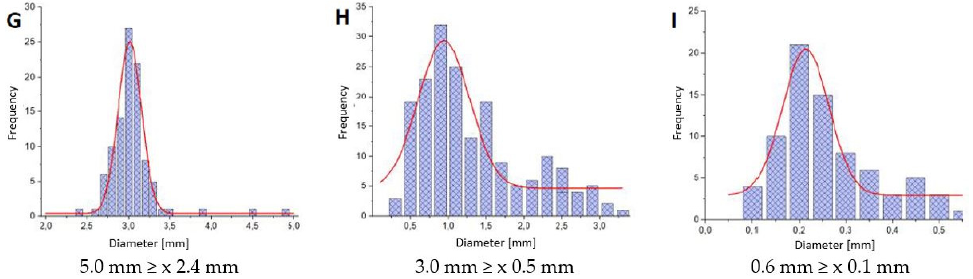
Figure 3. Photographic images of ( A ) PP- g -MA/F1 (80/20)-G (granules), ( B ) PP- g -MA/F1 (80/20)-C (crushed) and ( C ) PP- g -MA/F1 (80/20) (powder); SEM images of ( D ) PP- g -MA/F1 (80/20)-G, ( E ) PP- g -MA/F1 (80/20)-C and ( F ) PP- g -MA/F1 (80/20); and particle size distribution of ( G ) the pellet diameter of PP- g -MA/F1 (80/20)-G, ( H ) particle size of PP- g -MA/F1 (80/20)-C and ( I ) particle size of PP- g -MA/F1 (80/20). Table 5 summarizes the kinetic parameters determined from conversion–time curves